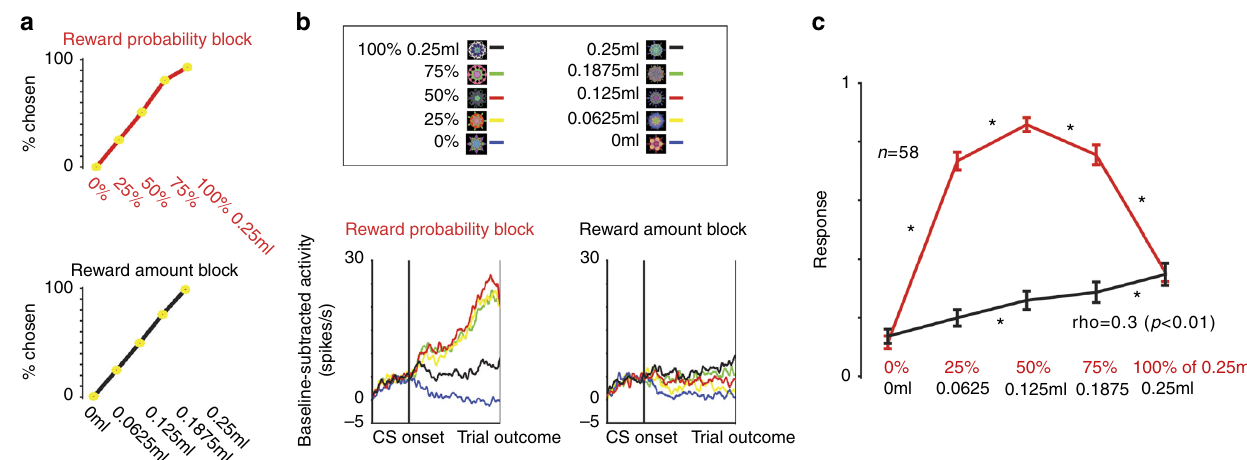
Fig. 6 Reward uncertainty ACC neurons are sensitive to the level of uncertainty. a Monkeys ’ choice preference between CSs associated with different reward amounts and probabilities. Choice percentage of a single reward probability CS ( x -axis) vs. all other reward probability CSs ( top ). Choice percentage of a single reward amount CS vs. all other reward amount CSs ( bottom ). Data are compiled from a data set of 13407 choice trials. b Average responses of 58 reward uncertainty-enhanced ACC neurons in the reward-probability block ( left ) and reward amount block ( right ). c Average normalized responses of the same neurons in the probability ( red ) and amount ( black ) CSs. Asterisks indicate differences between adjacent CSs ( p < 0.05; paired sign-rank test). The result of a Spearman ’ s rank correlation assessing the relationship of neuronal fi ring and reward amount in the reward amount block is indicated below. Before averaging, single neuronal responses were normalized to the maximum CS response, from 0 to 1, across the ten different CSs. Error bars indicate standard